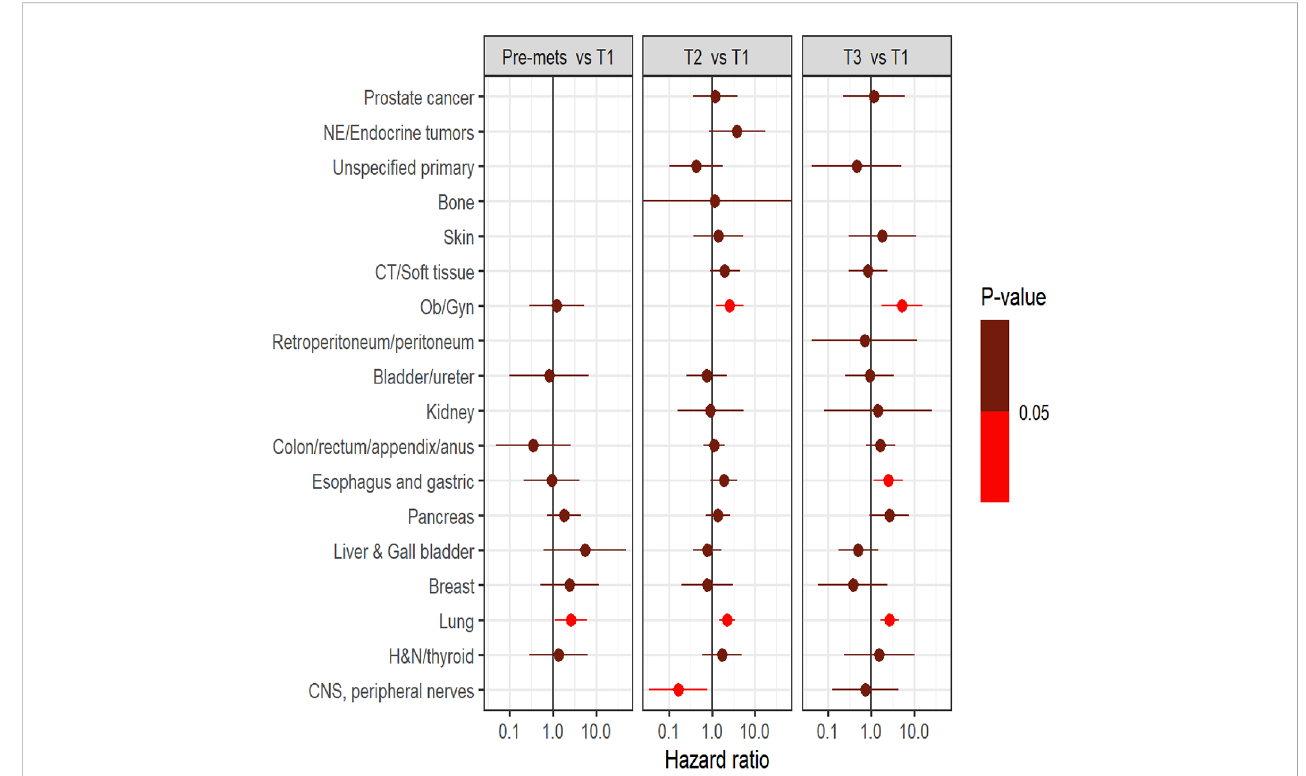
FIGURE 6 Comparison of survival outcome between groups (pre-mets, three tertiles namely T1, T2, and T3) within each diagnostic category.